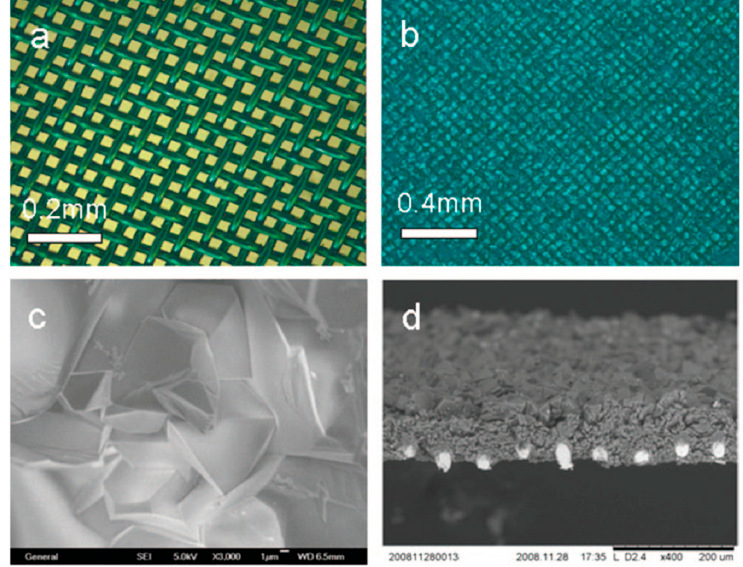
Figure 2. Optic micrographs of the ( a ) copper net and ( b ) net-supported Cu 3 (BTC) 2 membrane; SEM images of ( c ) the surface and ( d ) a cross section of the membrane. Reprinted with permission from Reference [52]. Copyright 2009 the American Chemical Society, (Washington, DC, USA).